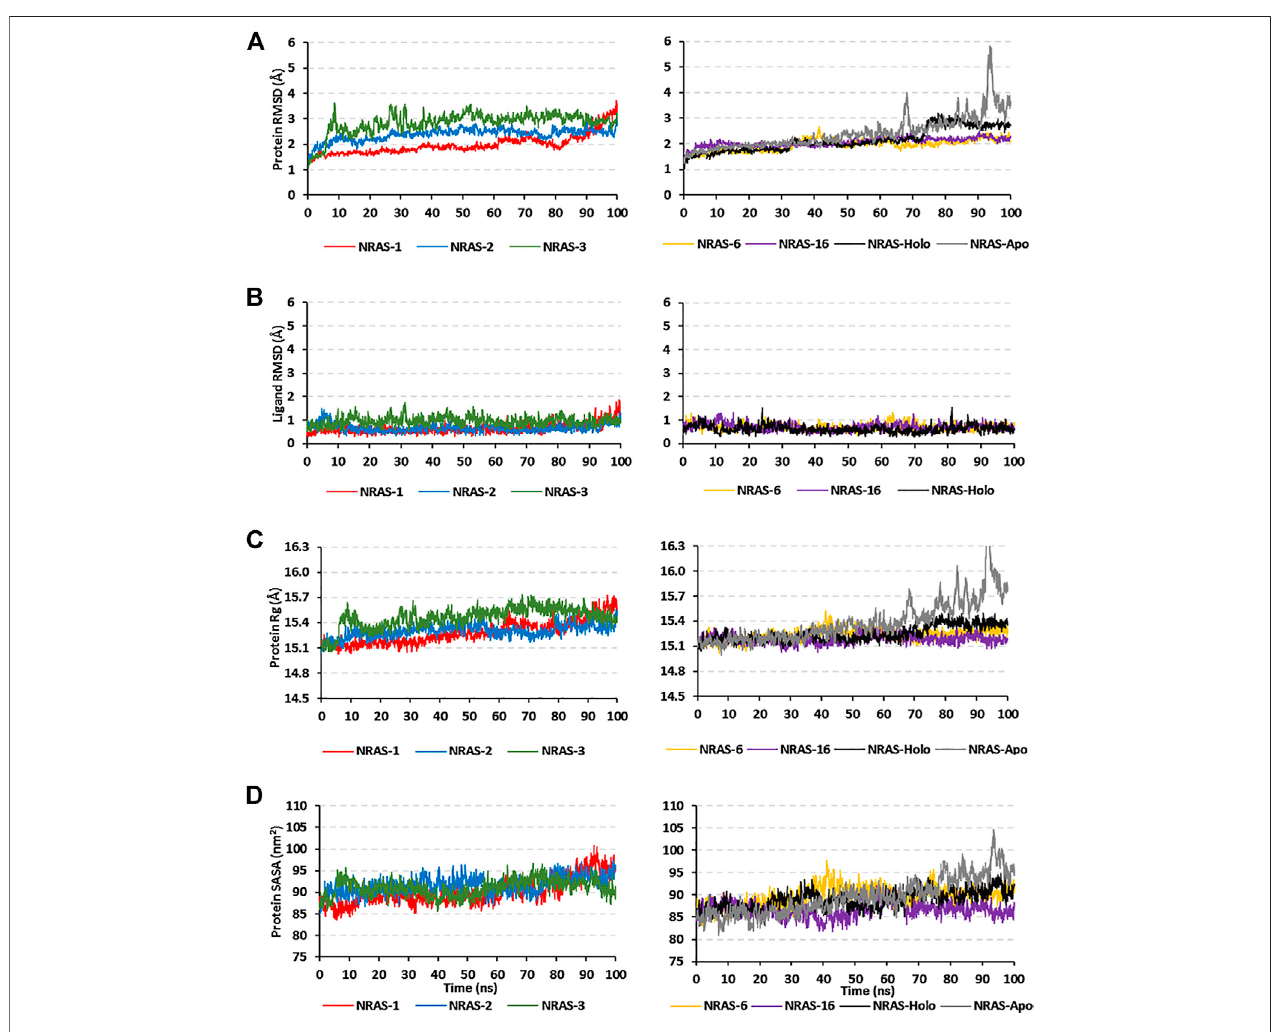
FIGURE 2 | Trajectory analysis for the simulated GTPase NRAS models. Monitored alpha-carbon trajectories of (A) protein ’ s RMSD, (B) ligand ’ s RMSD, (C) protein ’ s Rg, and (D) protein ’ s SASA were plotted against the entire molecular dynamics simulation timelines (100 ns).